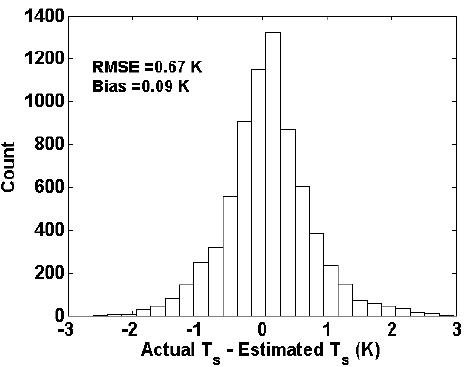
Figure 15. Histogram of the error between the actual LST and the estimation using Equations (11) and (12).